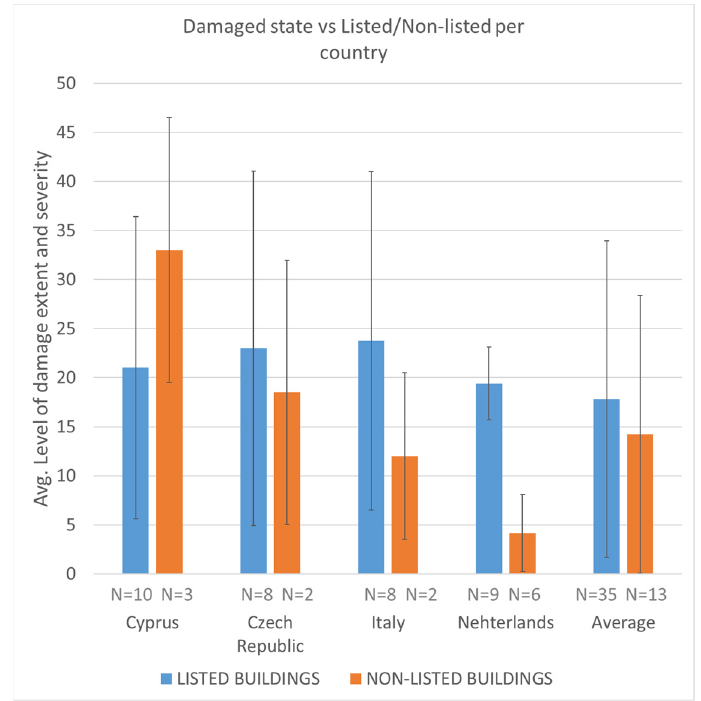
Figure 10. Level of damage severity vs. Building protection per country.